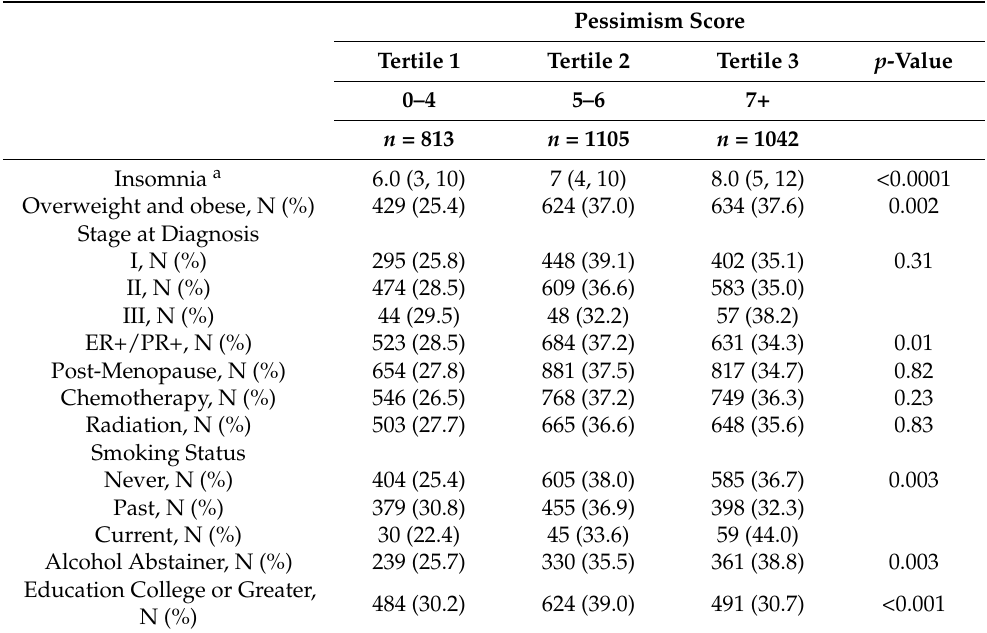
Table 2. Baseline characteristics according to pessimism score in the WHEL study ( n =